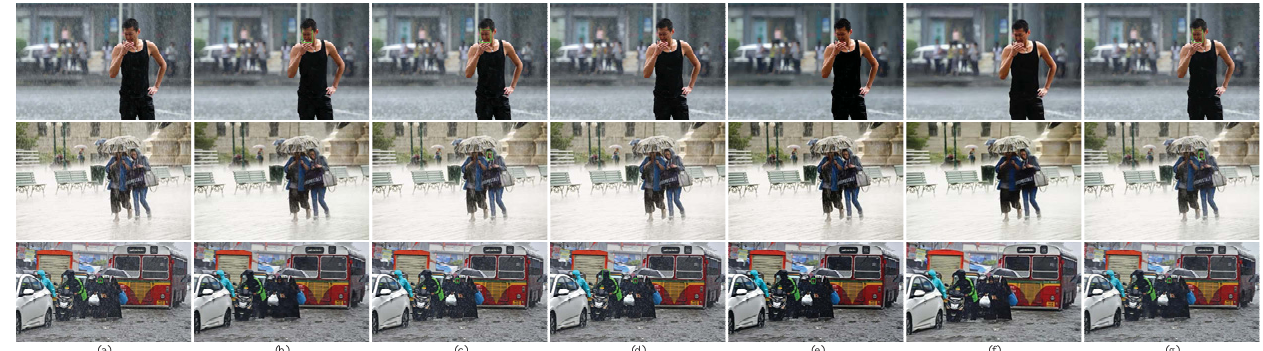
Figure 11. The visualization results of face detection by MTCNN [65] for images from different deraining methods. ( a ) Rain image. ( b – f ) Results from RESCAN [12], MPRNet [16], PCNet [17], ReMAEN [32], DID-MDN [40]. ( g ) Object detection result from our method. Please zoom in to see clearly.